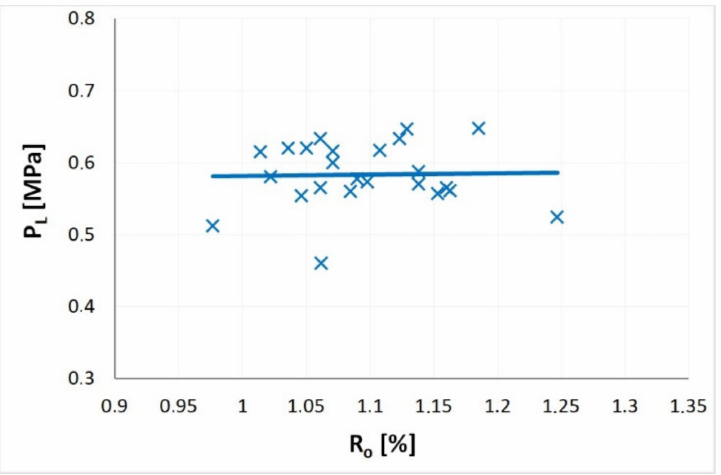
Figure 7. The influence of coalification degree on the Langmuir half sorption pressure ( P L